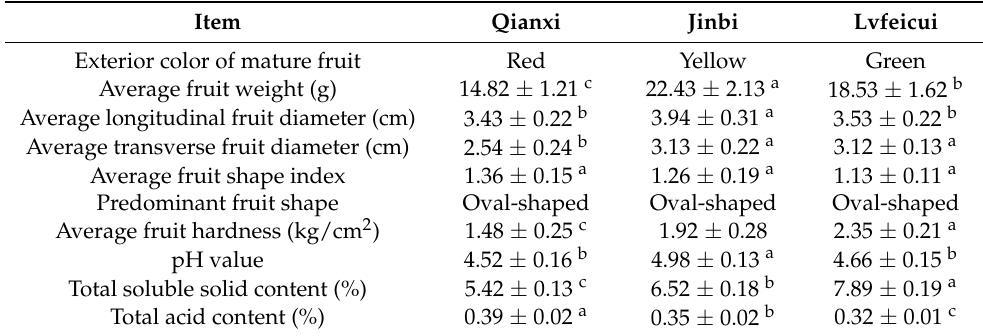
Table 1. Morphological characteristics, pH value, total soluble solid content, and total acid content of cherry tomatoes. Item Qianxi Jinbi